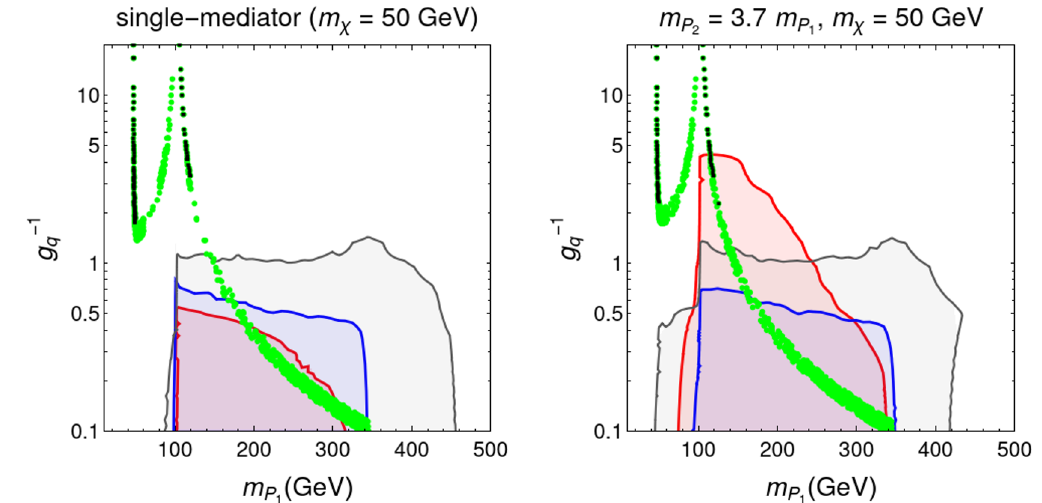
Figure 3 . Constraints on the model that originate from dark matter relic density, indirect detection and searches at the LHC. The results are shown in the plane (cid:0) m (left) and the two-mediator (right) case. The points appearing in light green are associated with a relic density satisfying Ω h 2 = 0 . 12 ± 10% , whereas the dark green points are additionally allowed by the indirect detection results of Fermi-LAT [56]. The shaded regions represent 95% confidence level exclusions from mono-jet (grey), mono-Higgs (red) and t ¯ t + /E LHC data